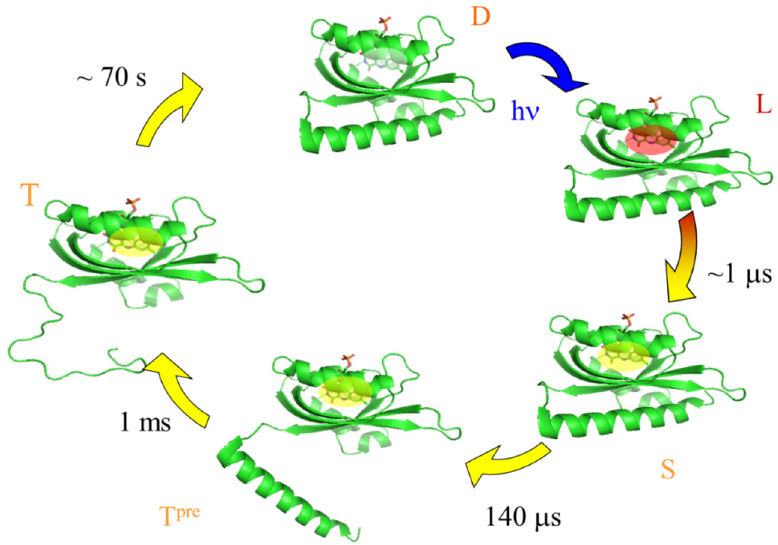
Figure 2. Photoreaction scheme of Phot1LOV2-linker.